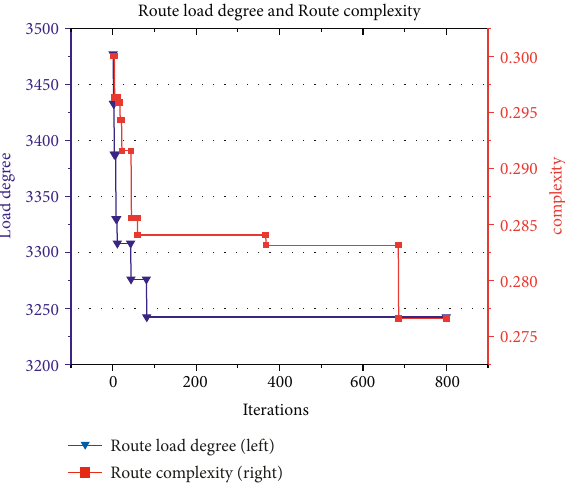
Figure 12: Changes in two